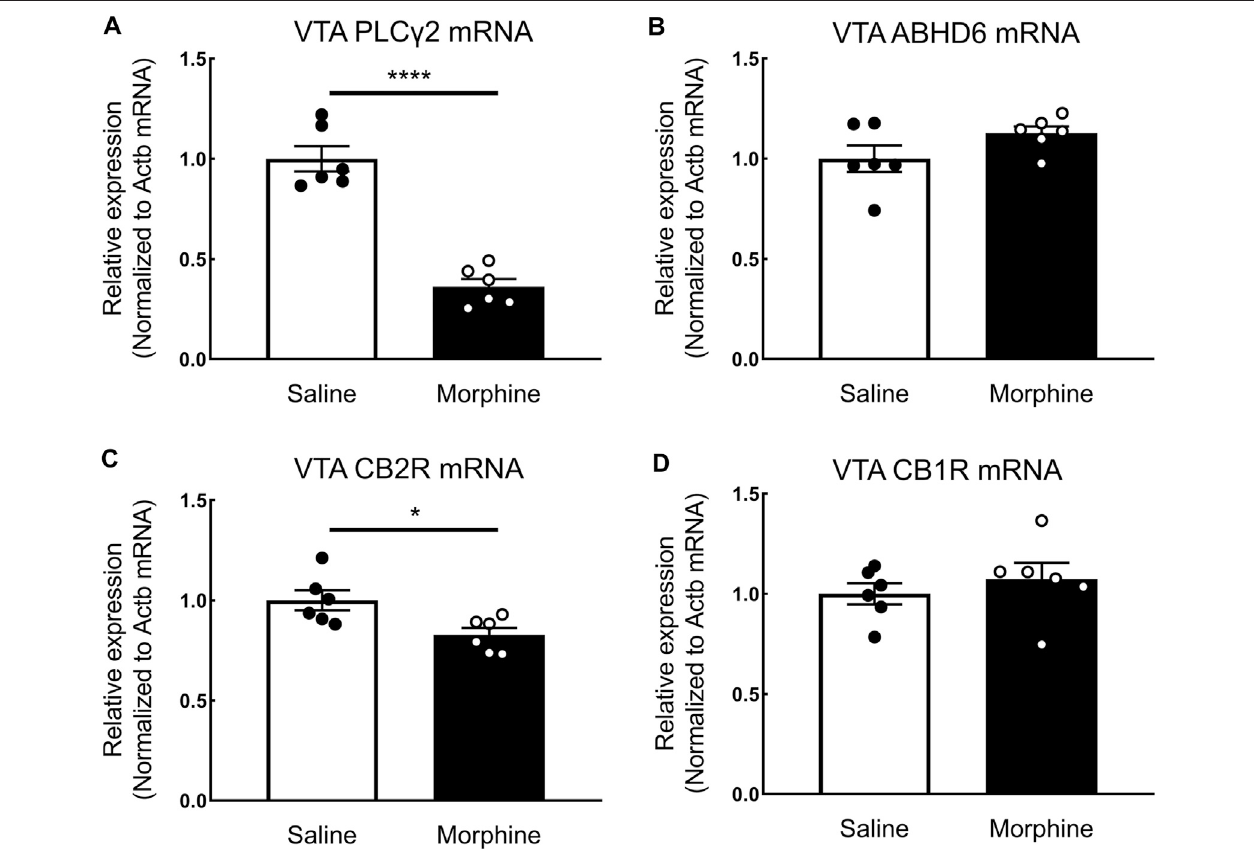
FIGURE 3 | The effects of sustained morphine on the mRNA expression of PLC γ 2, ABHD6, CB1Rs, and CB2Rs in the VTA. Rats were sacri fi ced after sustained morphine or saline treatment, and the VTA tissues were then collected and prepared for qRT-PCR analysis. Relative mRNA expression levels of (A) PLC γ 2, (B) ABHD6, (C) CB2R,and (D) CB1Rweredeterminedby ΔΔ CTmethod and normalized to β -actin mRNA level.PLC γ 2and CB2R mRNA expression wassigni fi cantly decreased in repeatedmorphinetreatment,butnosigni fi cantdifferenceinABHD6andCB1expressionwasobservedbetweentwotreatmentgroups.* p < 0.05,**** p < 0.0001, morphine vs. saline. Values represent the mean ± SEM, n (cid:1) 6 per group.